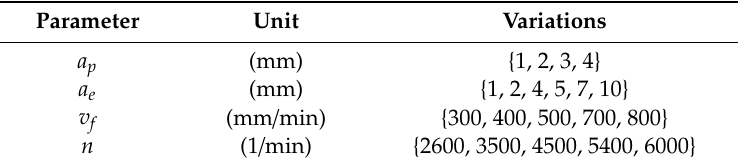
Table 1. Overview of process variations of recorded training